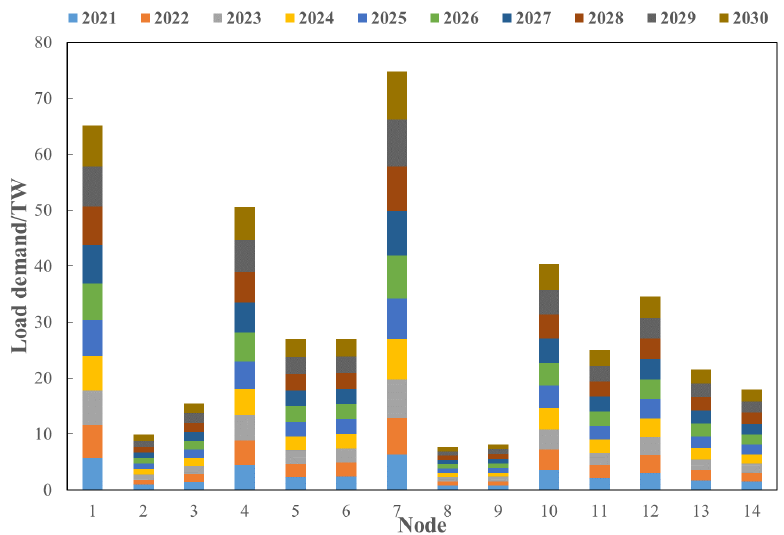
Figure 17. Load demand by node from 2020 to 2030.